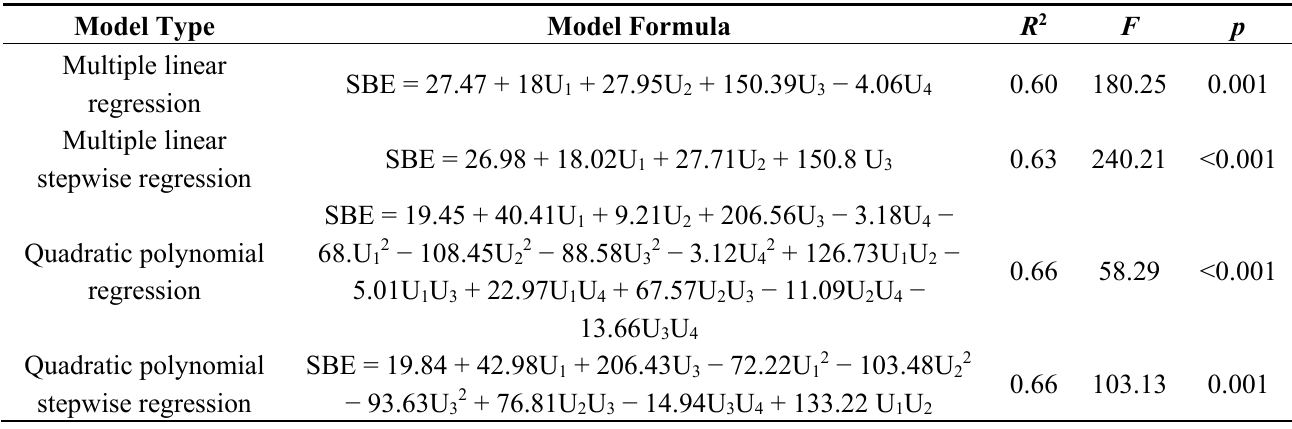
Table 7. Regression descriptions of independent variable number, model formula regression, and formula fitting status for quality traits of individual tree